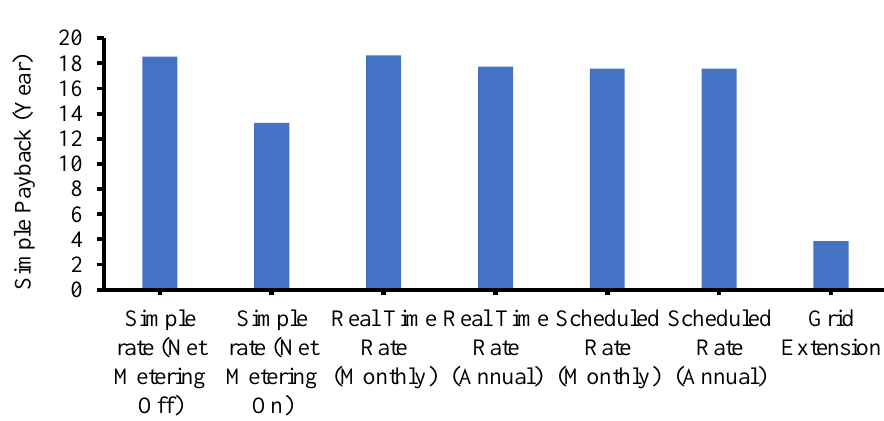
Figure 13. Return on investment (ROI) comparison.